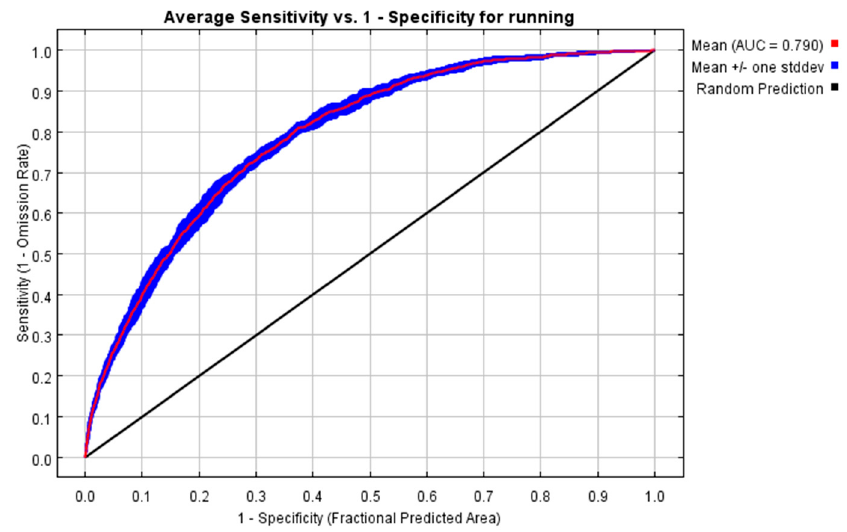
Figure 5. The AUC values derived from the Maxent models.